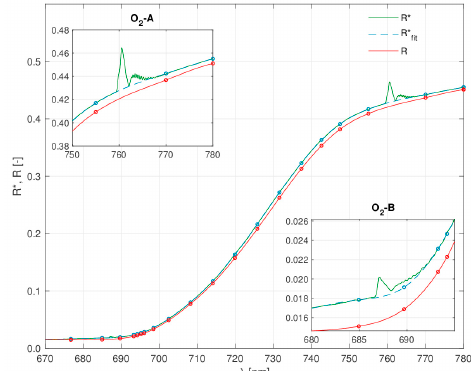
Figure 2. Apparent reflectance ( R * , dark green line ), spline fit of apparent reflectance ( R *fit , blue line ) and true reflectance ( R , light green ). Inner boxes show details at O 2 bands.